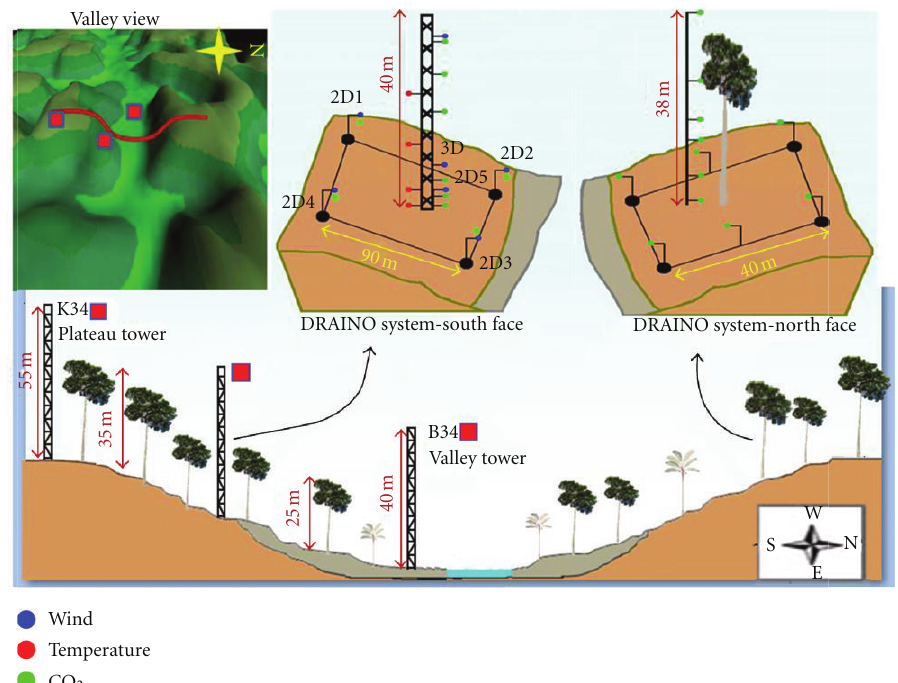
Figure 4: DRAINO measurement system (south and north slope face) implemented at the Manaus LBA site, including topographic view and instrumentation